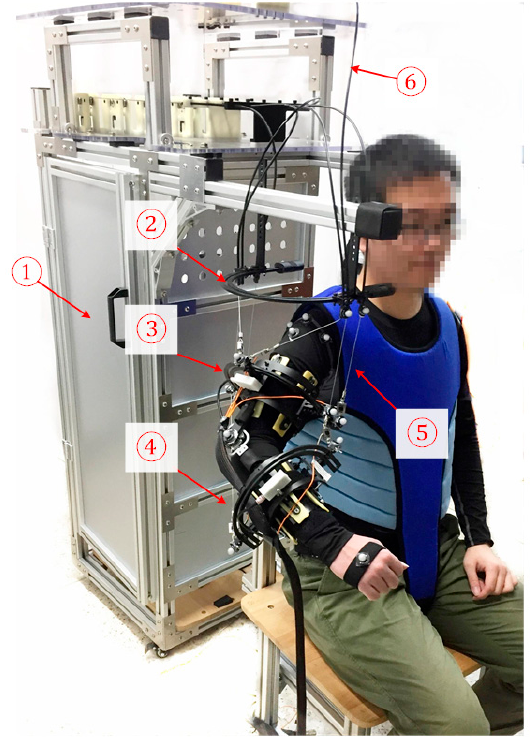
Figure 1. Cable-driven exoskeleton system constructed with (1) base frame, (2) base cuff, (3) upper-arm cuff, (4) forearm cuff, (5) cable, (6) Bowden cable.